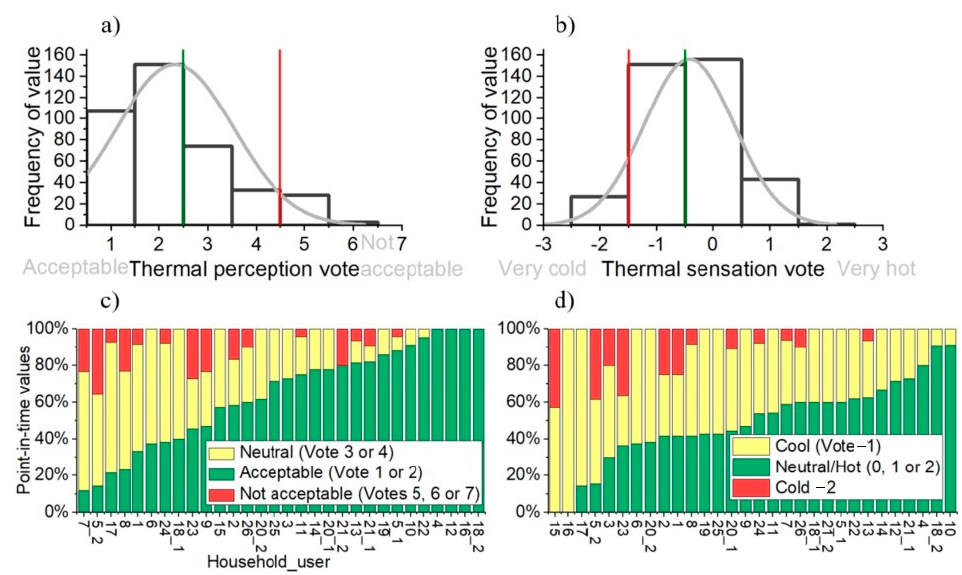
Figure 9. Votes for thermal perception ( a , c ) and sensation ( b , d ). General frequency of voting ( a , b ), and individuals participants votes ( c , d ). Code is given for household number and in homes where there is more than one participant there is also a participant number. Red line indicates the limit of non-acceptance: (a) votes 5 or above and (b) votes − 2 or below. Green line indicates limit of good acceptance: (a) votes 2 or below and (b) votes 0 or above.